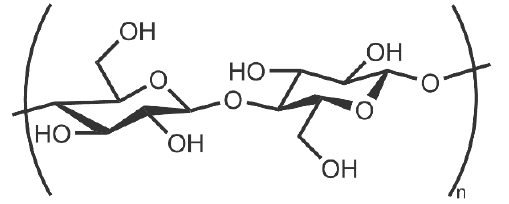
Figure 2. Monomer unit of cellulose.